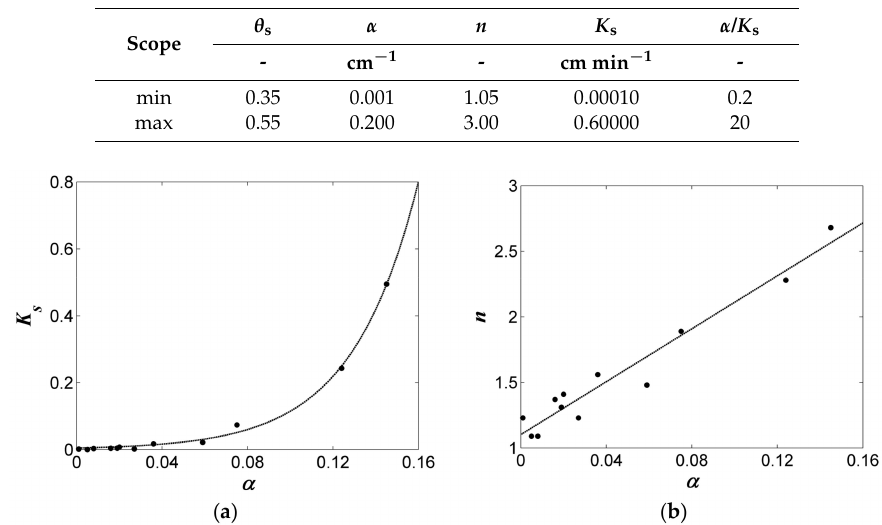
Table 2. Inverse scope of soil hydraulic parameters.